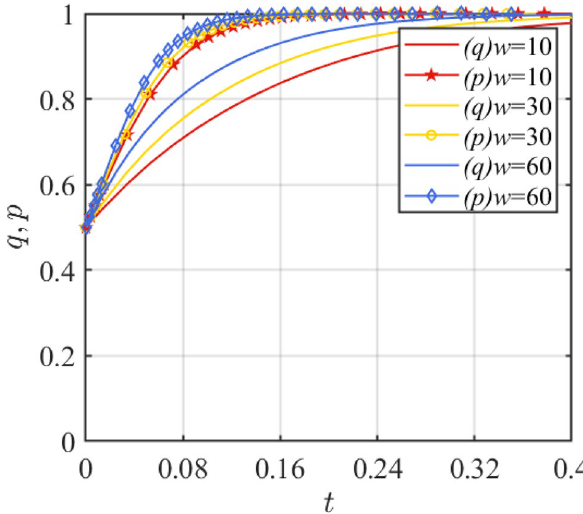
Figure 5. Effect of parameter w change.